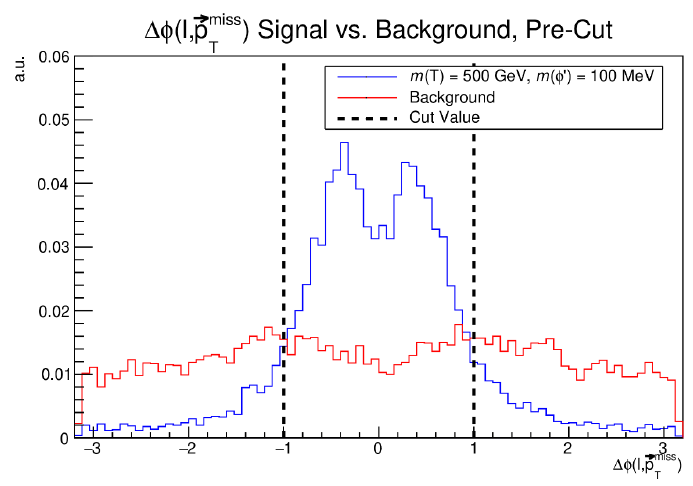
Figure 7 . Distribution of the angle between ‘ and ~p miss background (red) samples. Signal events were generated assuming m ( T ) = 500 GeV , m ( φ 0 ) = 100 MeV . The y -axis normalization is arbitrary. The vertical black dashed lines denotes the location of the selection